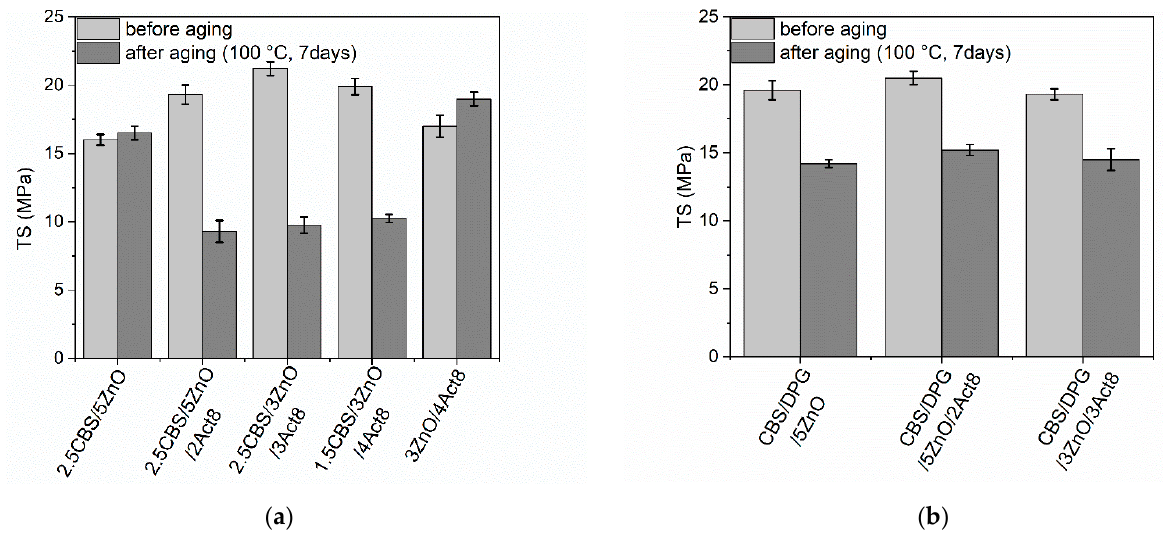
Figure 7. Influence of thermo-oxidative aging on the tensile strength (TS) of SBR vulcanizates containing: ( a ) CBS; ( b ) CBS and DPG.